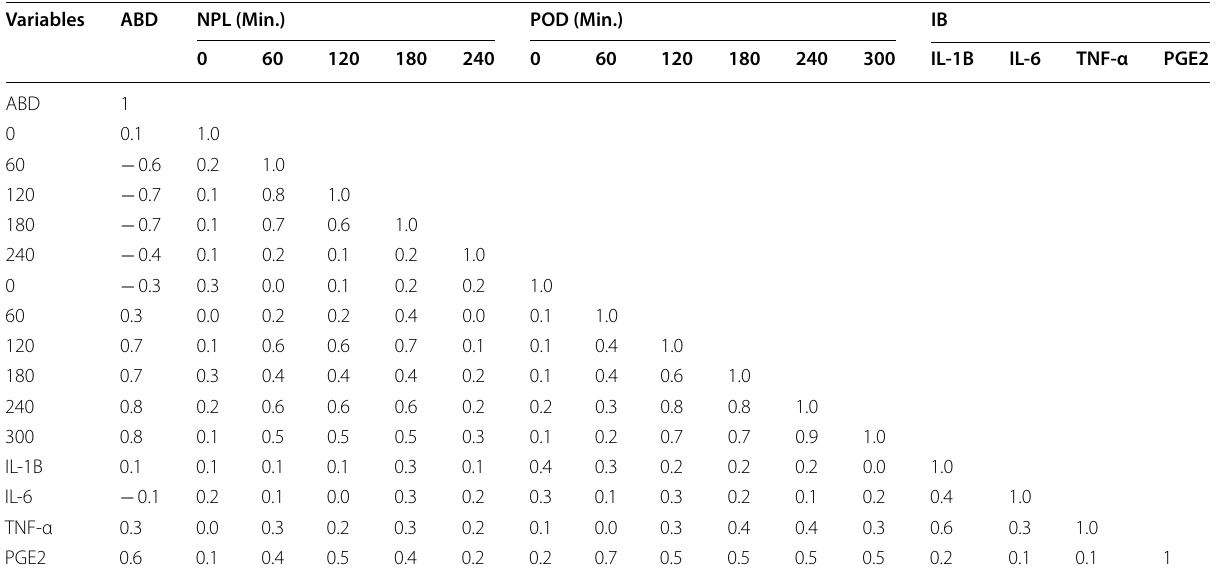
Table 1 Correlation analysis performance of the